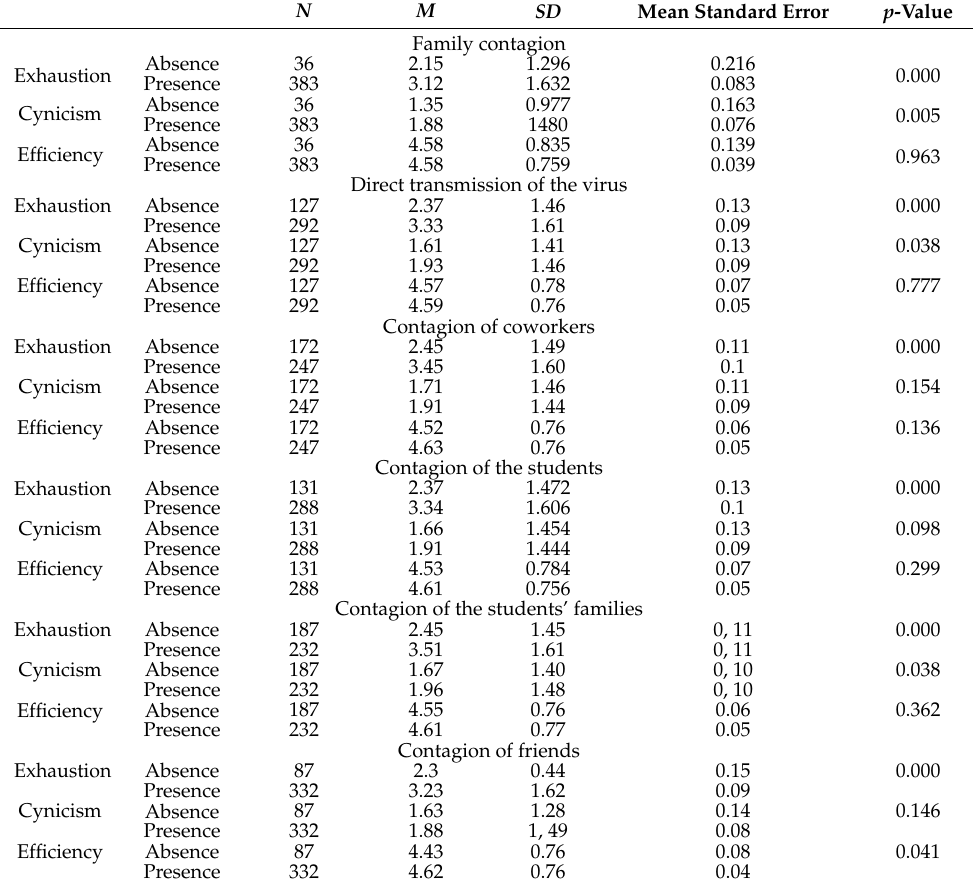
Table 1. Descriptive statistics and significance of Student’s t -test for burnout dimensions and stress associated with COVID-19. N M SD Mean Standard Error p